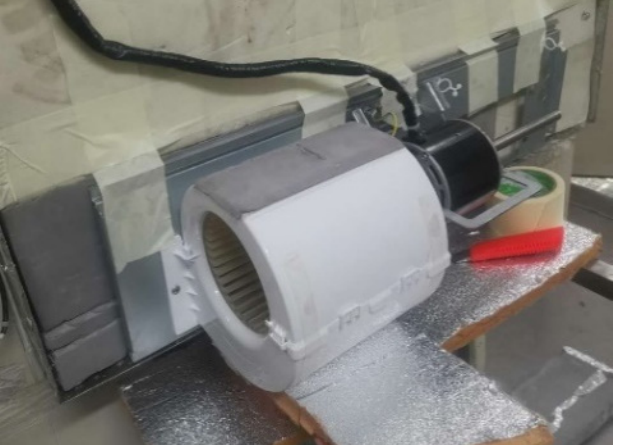
Figure 4. Installation of the tested fan.